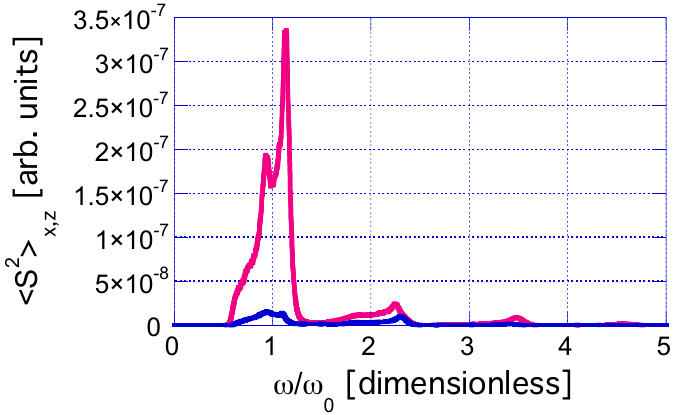
Figure 4. Averaged TS spectrum computed for a sample of 2048 trapped trajectories whose initial conditions are generated randomly inside a circle of radius w 0 /20, w 0 = 100.0 µ m. Averaged spectrum along x -axis is plotted in red, along z -axis in blue. The reference electric field of the ultra intense laser is E 0 = 3.63 × 10 13 V/m. A rather broad spectral band around ω / ω 0 = 1 and less intense contributions at higher harmonics are apparent. Spectrum is strongly polarized along the x -axis in this